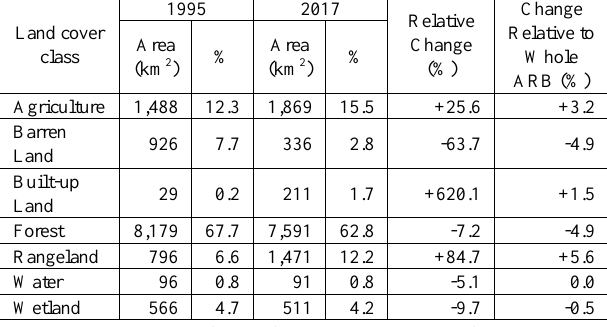
Table 4. Summary of classification area statistics for 1995 and 2017 for the whole ARB.